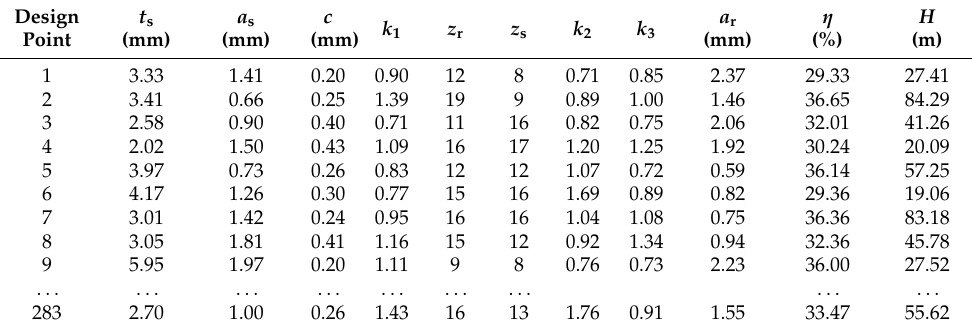
Table 3. Distribution of sample points and calculation